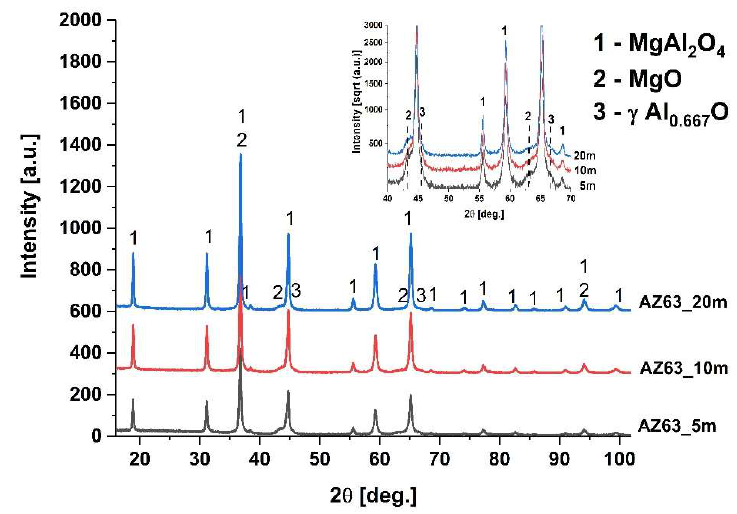
Figure 10. XRD patterns of the detached PEO coatings (inset: zoom on the 40 ◦ –70 ◦ 2 θ range).